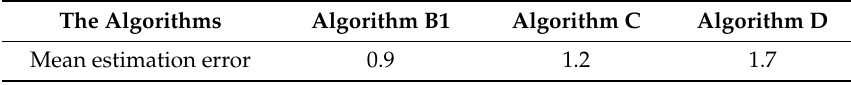
Figure 5. The estimation error curves of the fire source by the Algorithms B1, C, and D. Table 5. Mean estimation error of the fire source by the Algorithms B1, C, and